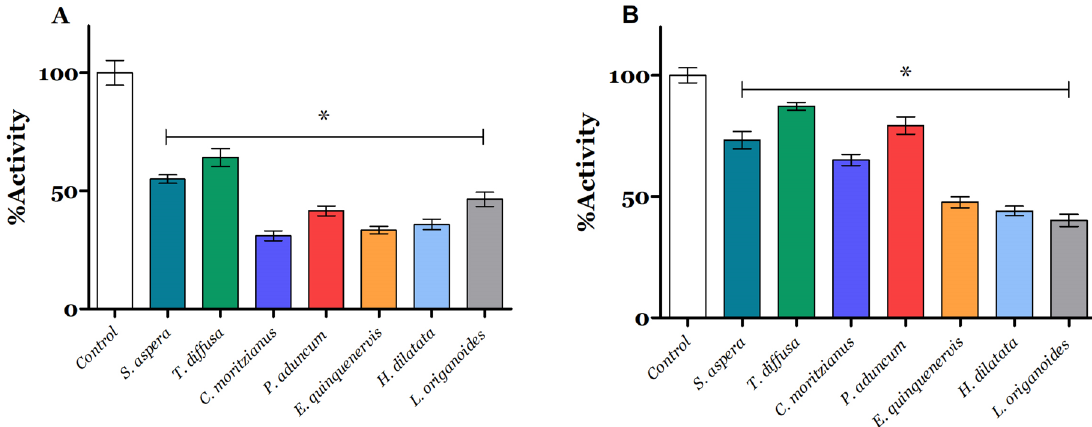
Figure 2. Effect of EOs on mitochondrial electron transport through the mitochondrial respiratory chain. ( A ) NADH oxidase activity; ( B ) Succinate oxidase activity. 100% activity represents 686.17 pmolO 2 /s*mg total protein and 620.88 pmolO 2 /s*mg total protein for NADH and succinate oxidase activity, respectively. Each value represents the mean ± SD of three independent experiments. *Significant statistical differences with respect to control p < 0.05.